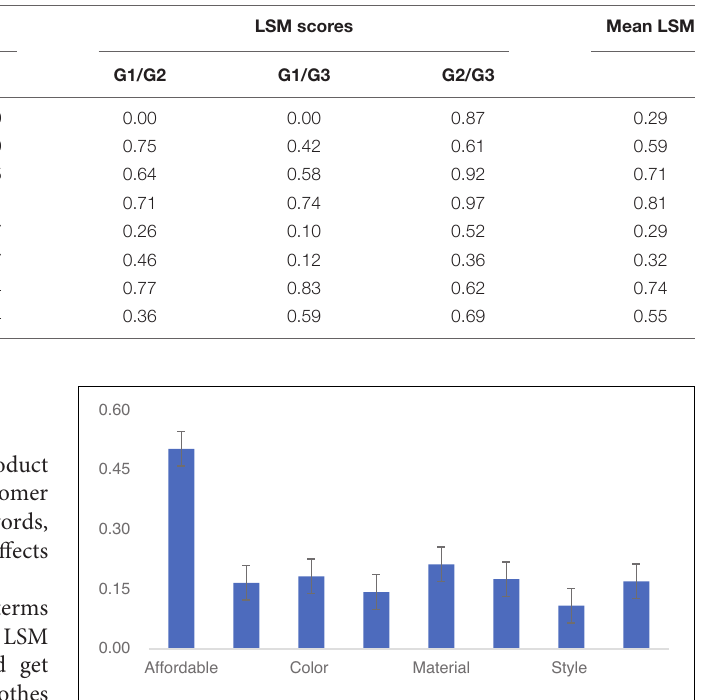
FIGURE 2 | The SD of three language style matching (LSM).